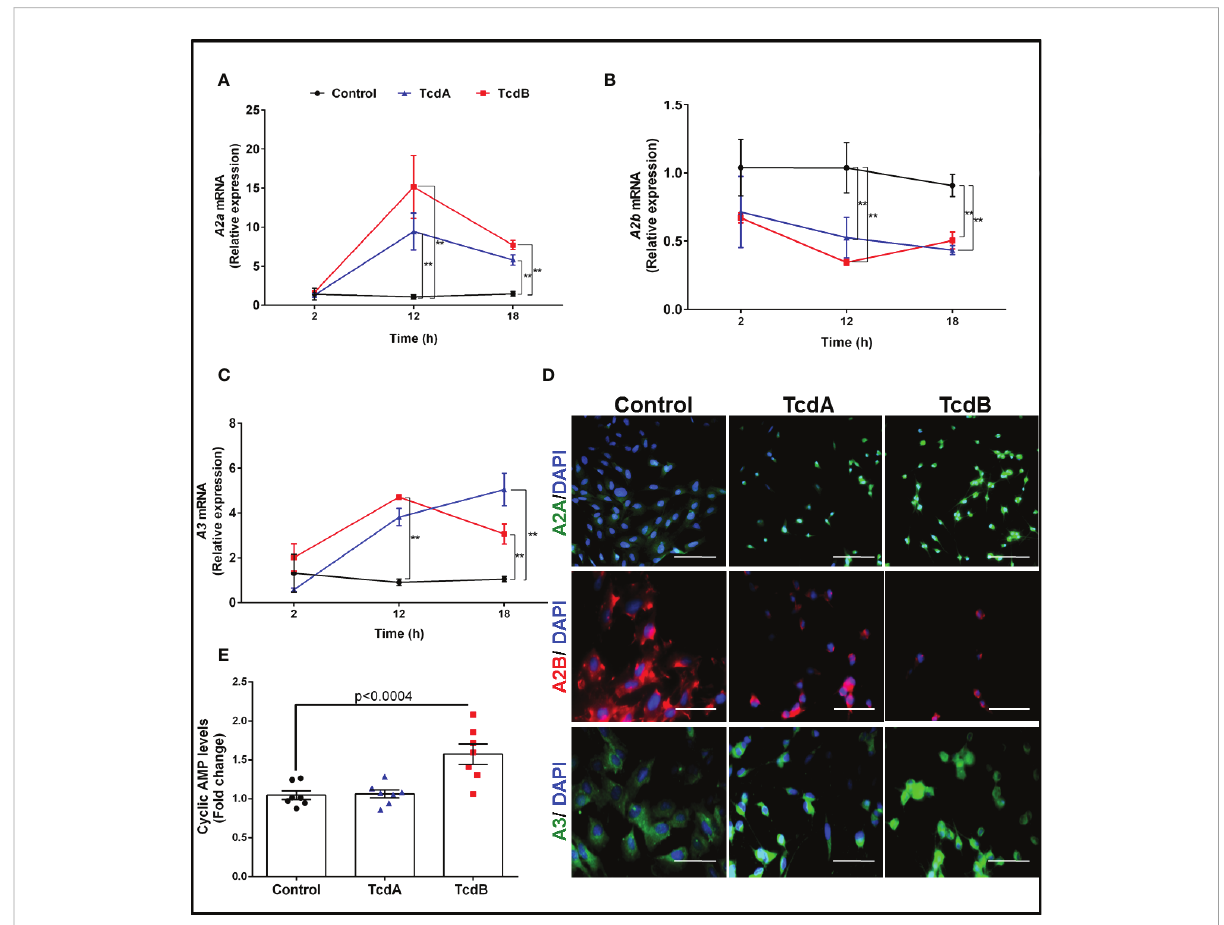
FIGURE 1 TcdA and TcdB upregulate expression of anti-in fl ammatory adenosine receptors (A2A and A3) and downregulate the proin fl ammatory adenosine receptor (A2B) in enteric glia in vitro . (A) Levels of A2A , (B) A2B and (C) A3 gene expression (mean ± s.e.m) by qPCR in EGC/ PK060399 challenged with TcdA (50 ng/mL) and TcdB (1 ng/mL) (n=6). Two-way ANOVA followed by Turkey test was used. (A – C) **p<0.0001. (D) Representative photomicrographs of A2A , A2B and A3 immunostaining, and DAPI (blue) as a nuclear staining in EGC exposed to TcdA and TcdB at 18 h incubation. Scale bars, 100 µm (A2A photomicrographs) and 50 µm (A2B and A3 photomicrographs). (E) cyclic AMP levels (mean ± s.e.m) evaluated by a luminescence assay in EGCs challenged with TcdA and TcdB at 18h incubation (n=6). One-way ANOVA followed by Turkey test was used. p value is indicated in the graph. These experiments are from three different